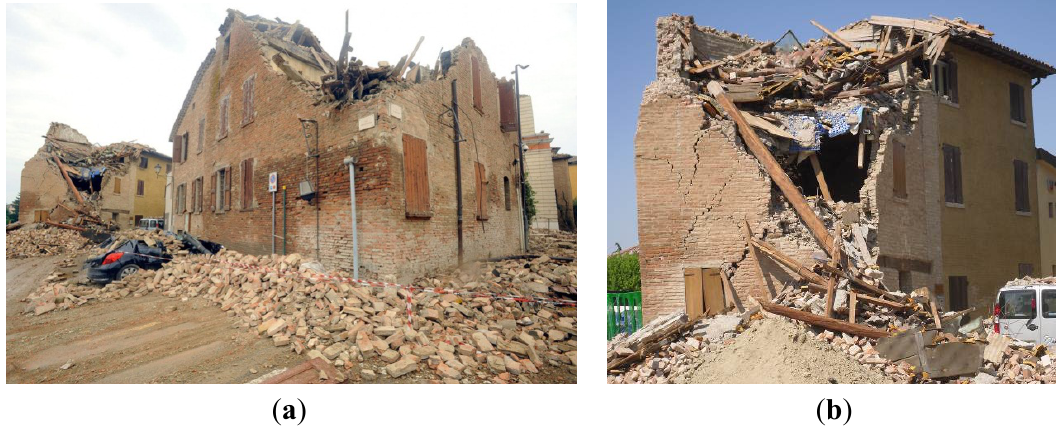
Figure 21. Out-of-plane corner mechanisms of brick masonry building units located in the historical center of San Felice sul Panaro: ( a ) Collapse of one story; ( b ) Collapse of two